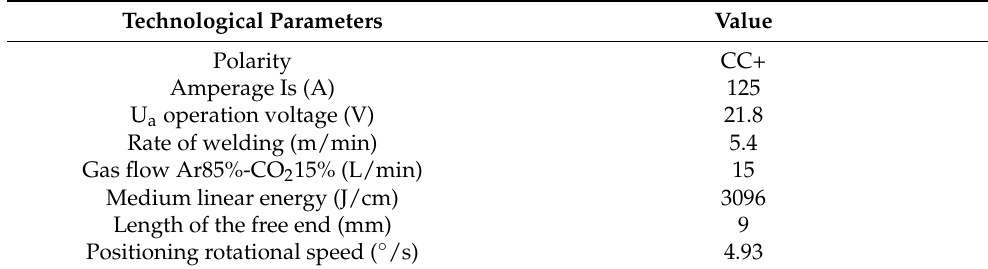
Table 1. Technological parameters of working procedure of wire arc additive manufacturing.